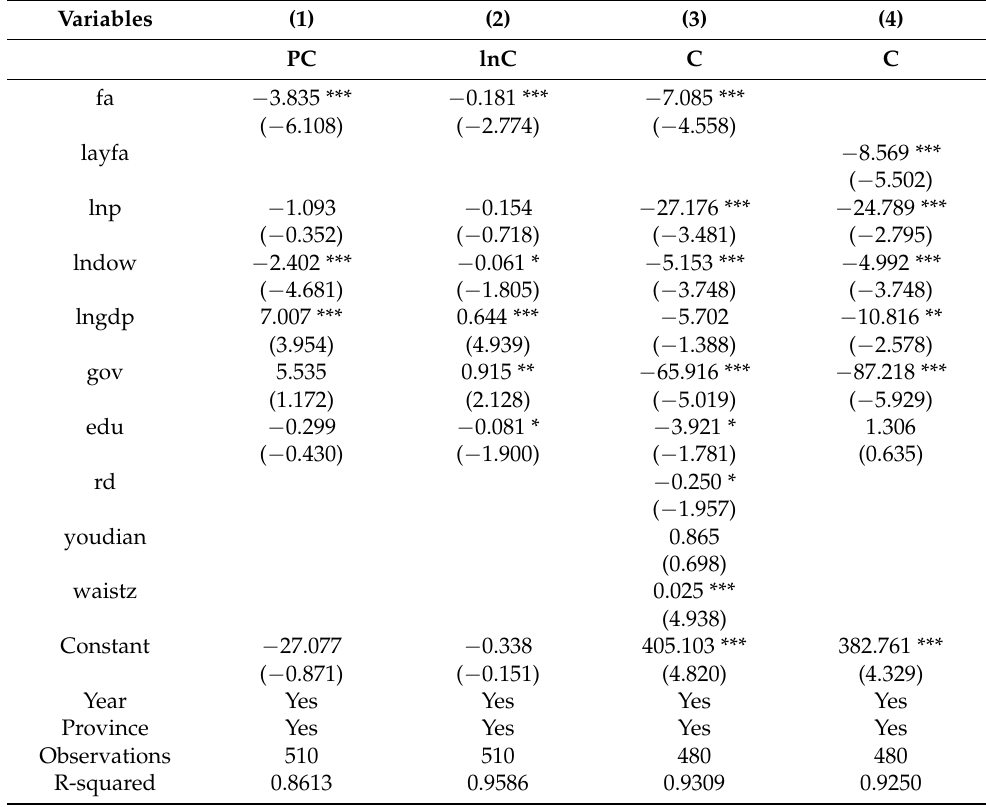
Table 3. Robustness